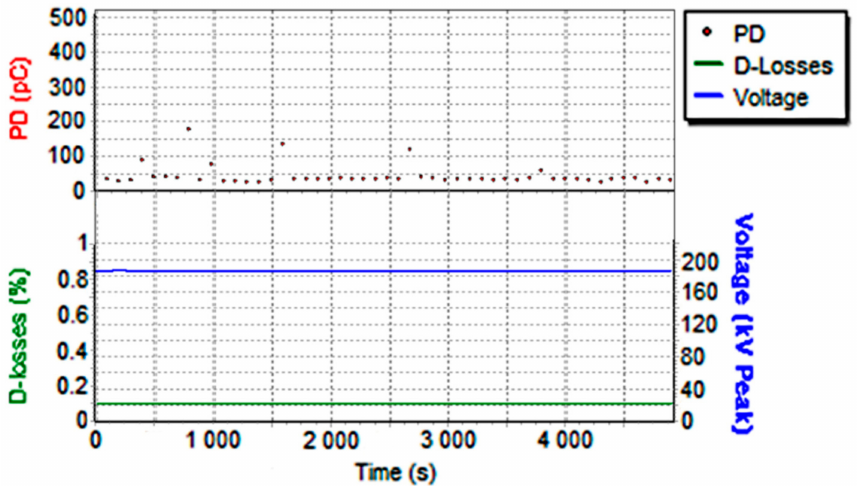
Figure 9. Test result overview of the PD-monitored voltage withstand test for 50 DAC excitations, with a duration of 1 h 25 min.